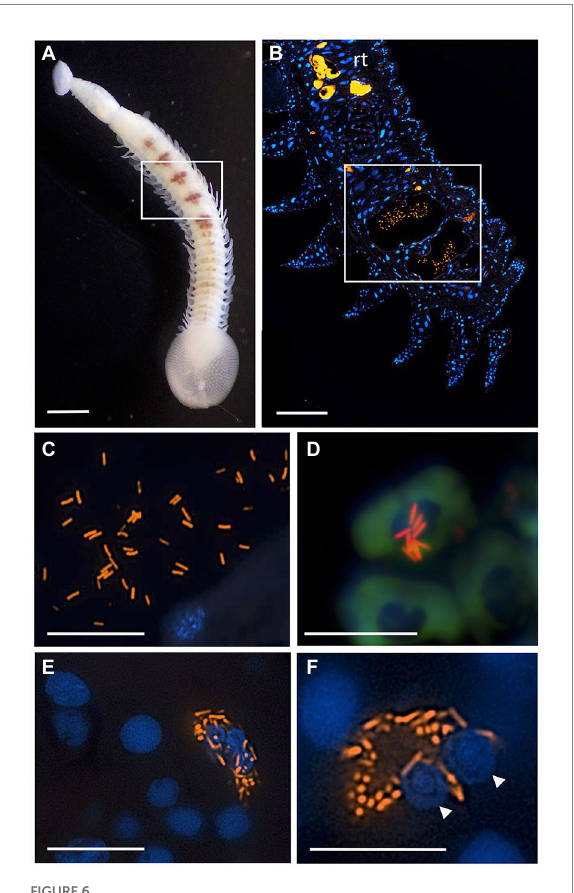
FIGURE 6 Fluorescent visualization and localization of Vibrio in (A) the elasmobranch leech Branchellion lobata . Square indicates regions of the crop filled with blood, as in B . Scale bar 1 mm. Taken with a Pentax WG-III handheld camera. (B) A partial longitudinal section through an individual, showing fluorescent hybridization using a Vibrio -specific probe to illuminate bacteria cells (shown in orange, via Cy3), with leech cell nuclei shown in blue ( via DAPI). Square indicates region in C–F . Scale bar 100 μ m. (C,D) A Vibrio -specific fluorescent probe revealed rod-shaped bacterial cells, shown in orange via Cy3, within the lumen space of the crop among bloodmeal (fish host blood cell shown in green, autofluorescence). (D) Vibrio cells appear to be on top of host cell and nucleus. (E,F) Within leech cells, sometimes in proximity to multiple nuclei (arrowheads), shown in blue via DAPI. C-F scale bars are 10 μ m. rt., autofluorescent reproductive tissues.